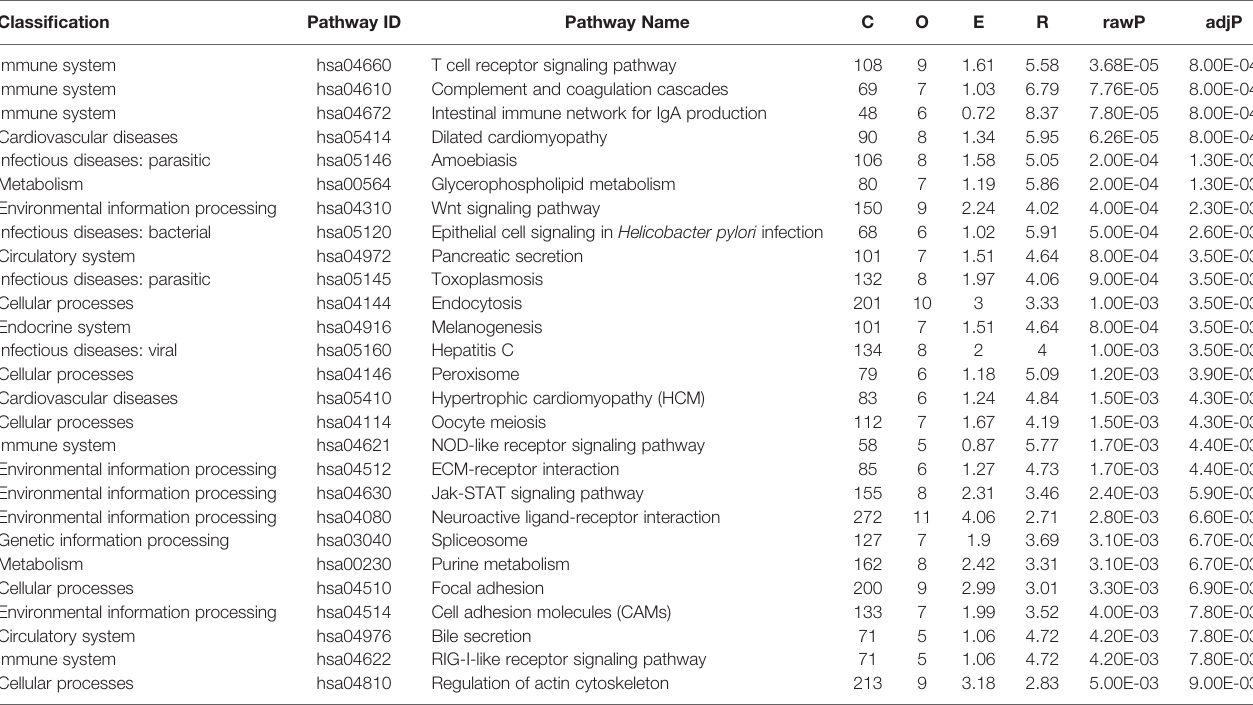
TABLE 1 | Signi fi cant KEGG pathways with P < 0.01 by pathway-based analysis of BMD GWAS. Classi fi